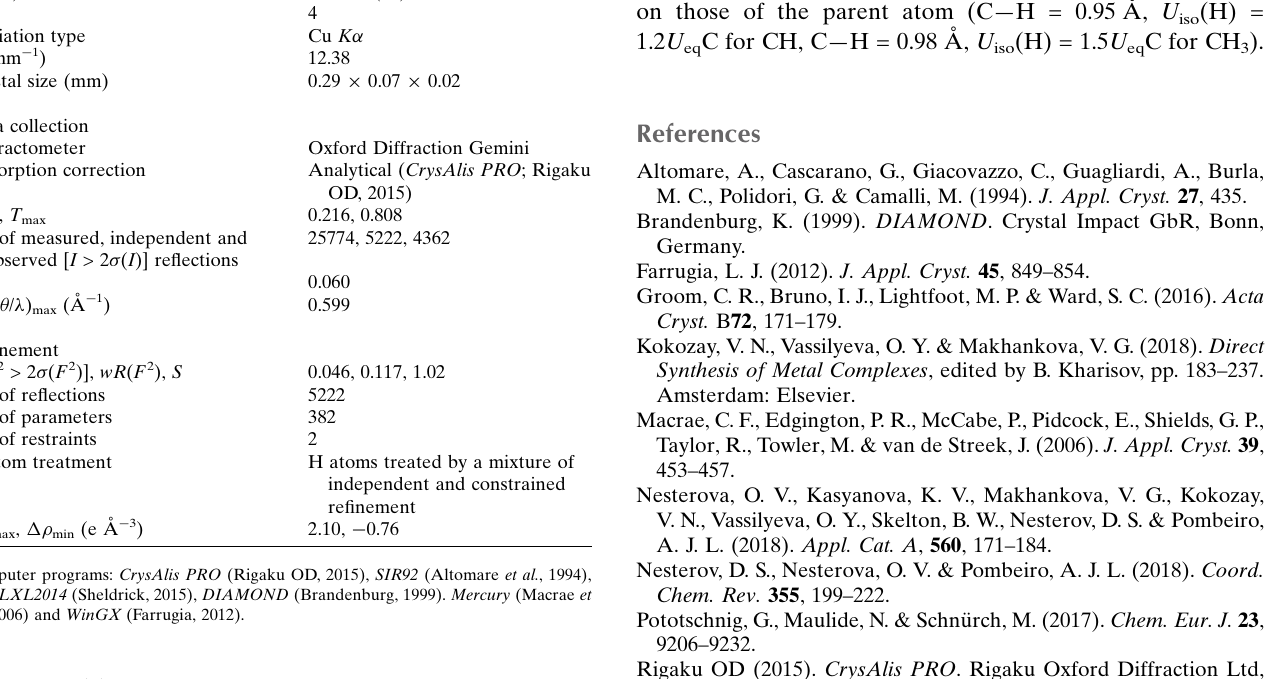
/ c settings. The water molecule compared in the standard P 2 1 hydrogen atoms in ( 1 ) were located and refined with geom- etries restrained to ideal values. All remaining hydrogen atoms were added at calculated positions and refined by use of